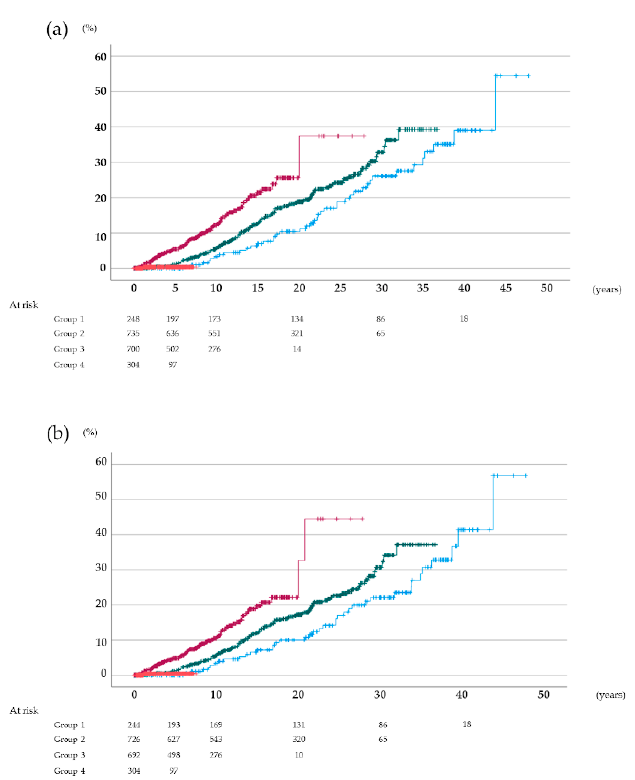
Figure 2. Cumulative cancer incidence rates after kidney transplantation. ( a ) all cancers, ( b ) all cancers except non-melanoma skin cancer: Blue, group 1; green, group 2; dark red, group 3; vermilion, group 4.